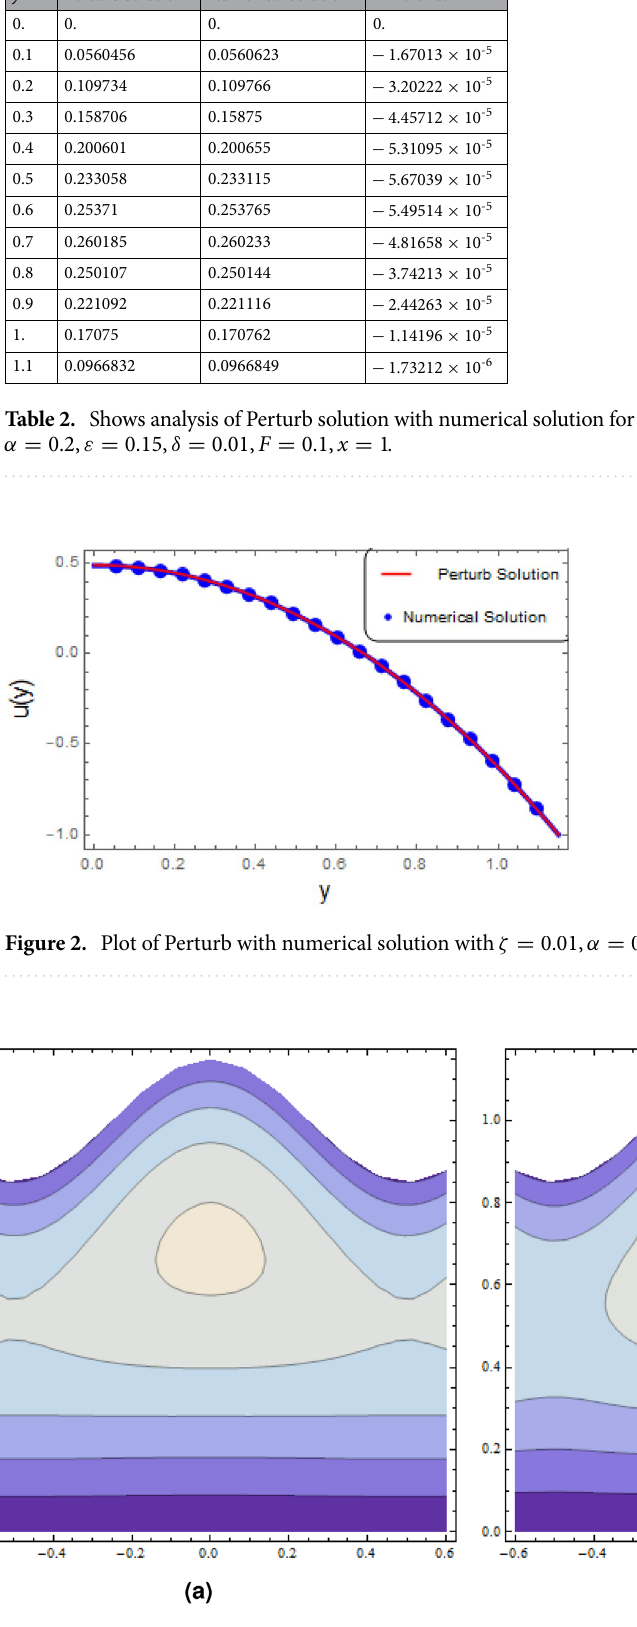
Figure 3. Plots of several stream lines with α = 0.2 , ε = 0.15 , F = 0.1 , δ = 0.05 , ( a ) ζ = 0 , ( b ) ζ = 0.01